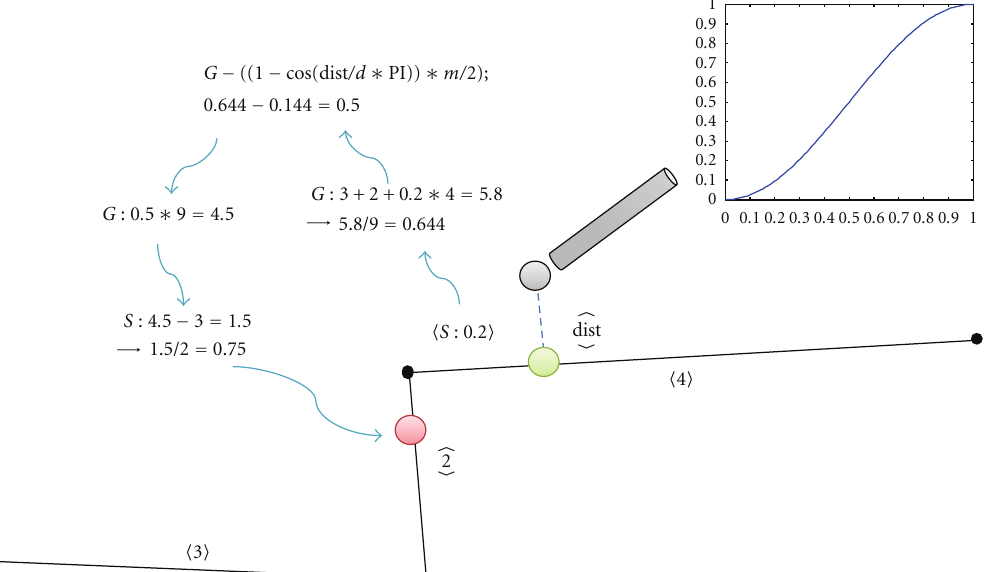
Figure 3: The pullback